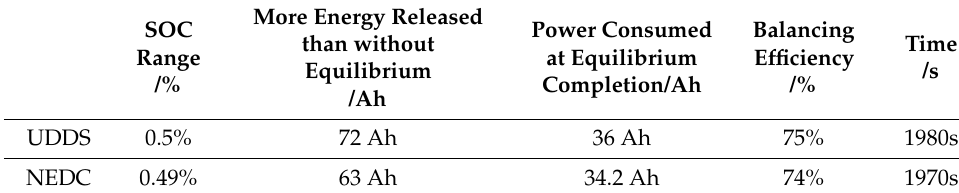
Table 7. Equilibrium results under NEDC and UDDS conditions .